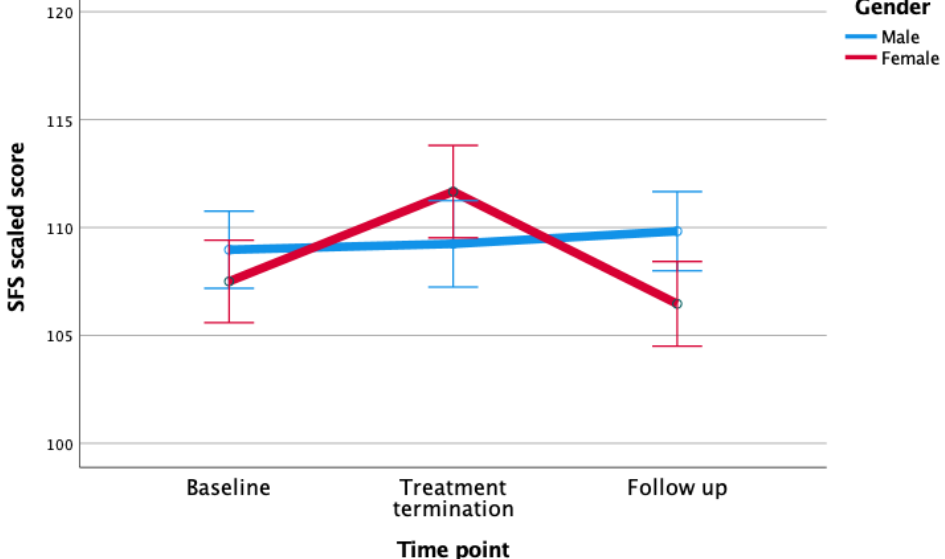
Figure 3. SFS by gender. SFS scores significantly differed from baseline to treatment termination among female participants ( P =.04). SFS: social functioning